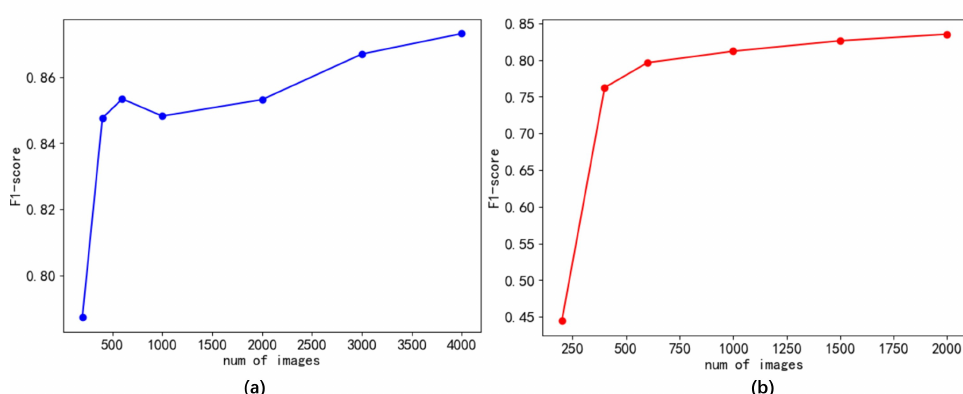
Figure 12. Effects of the data volume. ( a ) LEVIR dataset. ( b ) WHU